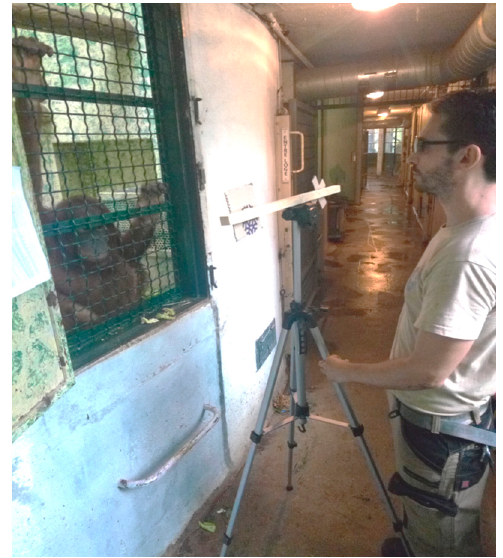
Figure 3. Apparatus used for Experiment 2. The picture shows the wooden perch with the two shaped cardboard stimuli being presented on the extremities. The zoo keeper presents the subject with the apparatus and stimuli.